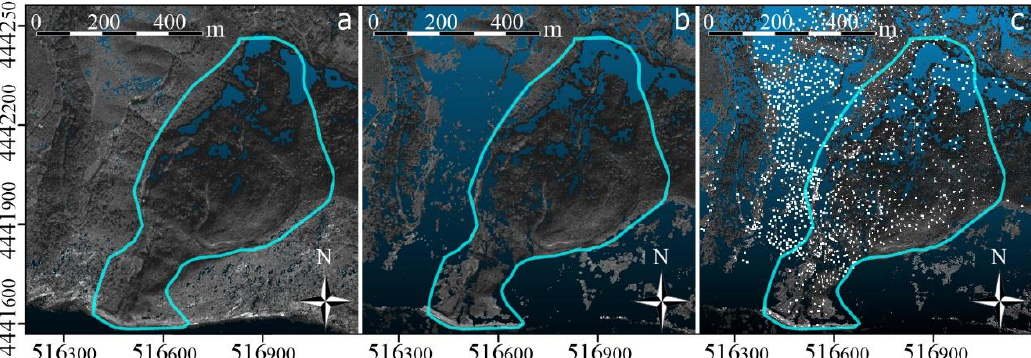
Figure 4. Sub-area GeoEye subjected to filtering. ( a ) Matched points that form the DSM. ( b ) The ground points after applying the filter. ( c ) One thousand six hundred and nine points (white dots) manually measured in the stereo model. The boundary of the interpolated area is shown in blue.